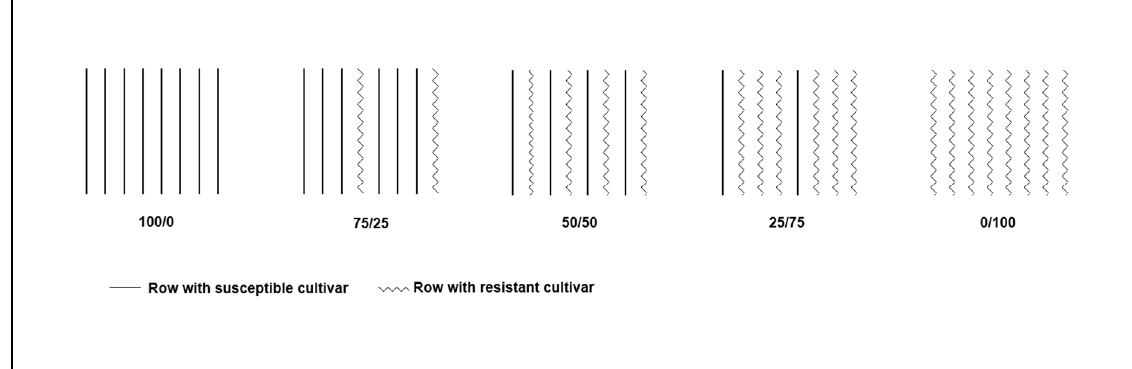
Figure 2. Experimental design for cultivar mixture experiments. Proportions are for Messire/Eritreo cultivars.